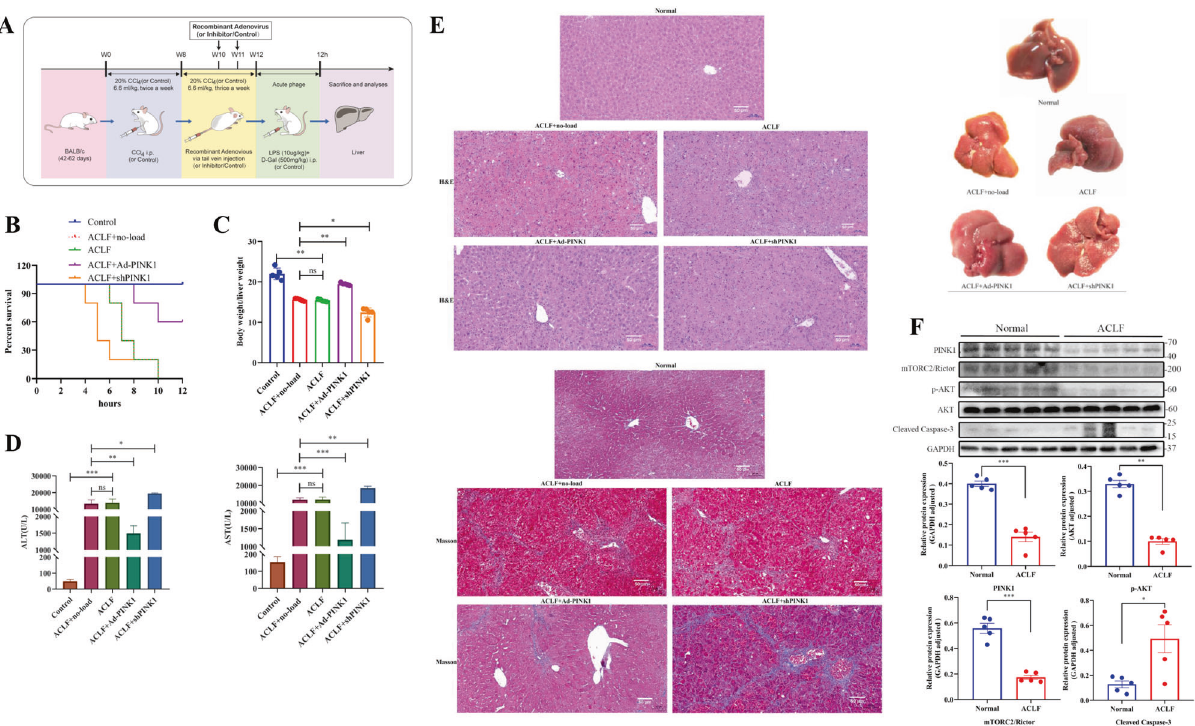
Fig. 6 In vivo experiments con fi rmed the results of the above in vitro fi ndings. A Schematic representation of mouse model establishment and lentivirus injection. B Survival rates in the normal, ACLF + no-load, ACLF, ACLF + Ad-PINK1, and ACLF + shPINK1 mouse groups. C Body- to-liver weight ratio in the control group. D Serum ALT and AST levels. E Morphological comparison of liver samples among the normal, ACLF + no-load, ACLF, ACLF + Ad-PINK1, and ACLF + shPINK1 groups (scale bar, 50 µm). F WB experiments were performed to evaluate changes in PINK1, mTORC2, p-AKT, and cleaved caspase-3 expression. * P < 0.05; ** P < 0.01; *** P < 0.001; **** P < 0.0001; ns not signi fi